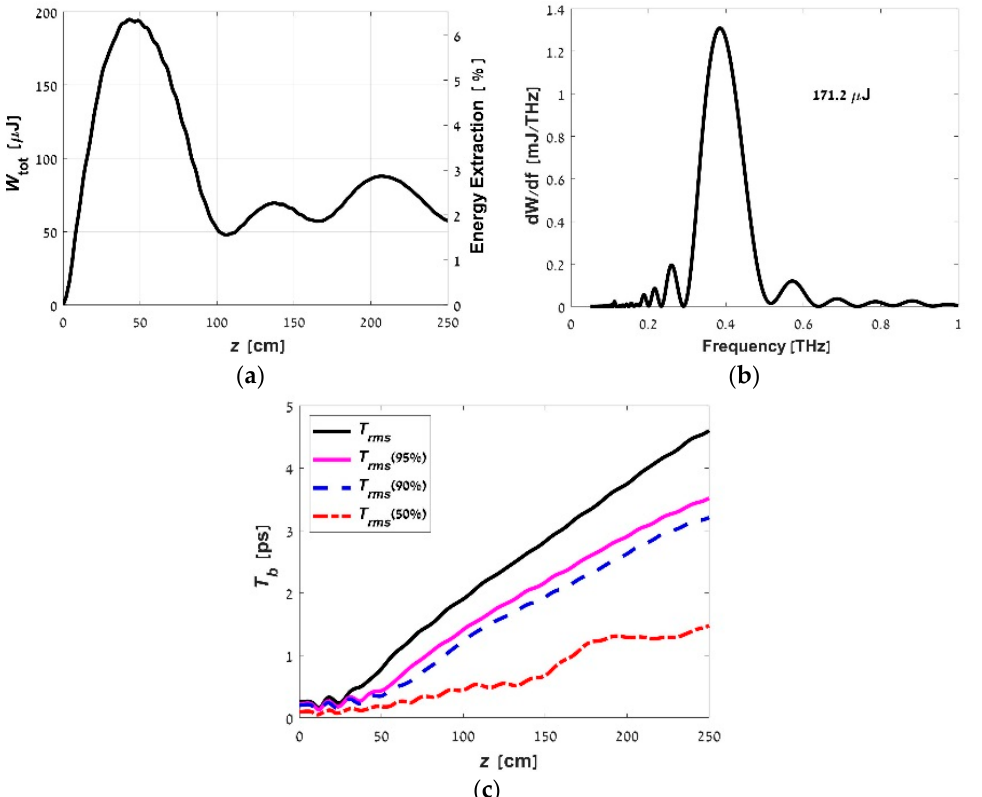
Figure 7. Undulator CSR of a bunch with a diameter of 1 mm, an initial duration of 0.25 ps, a charge of 0.5 nC, and a particle energy of 6 MeV in the group synchronism regime with the TE11 mode of a cylindrical waveguide with a diameter of 4 mm: ( a ) radiated energy, ( b ) emission spectrum, and ( c ) change in the rms bunch durations.